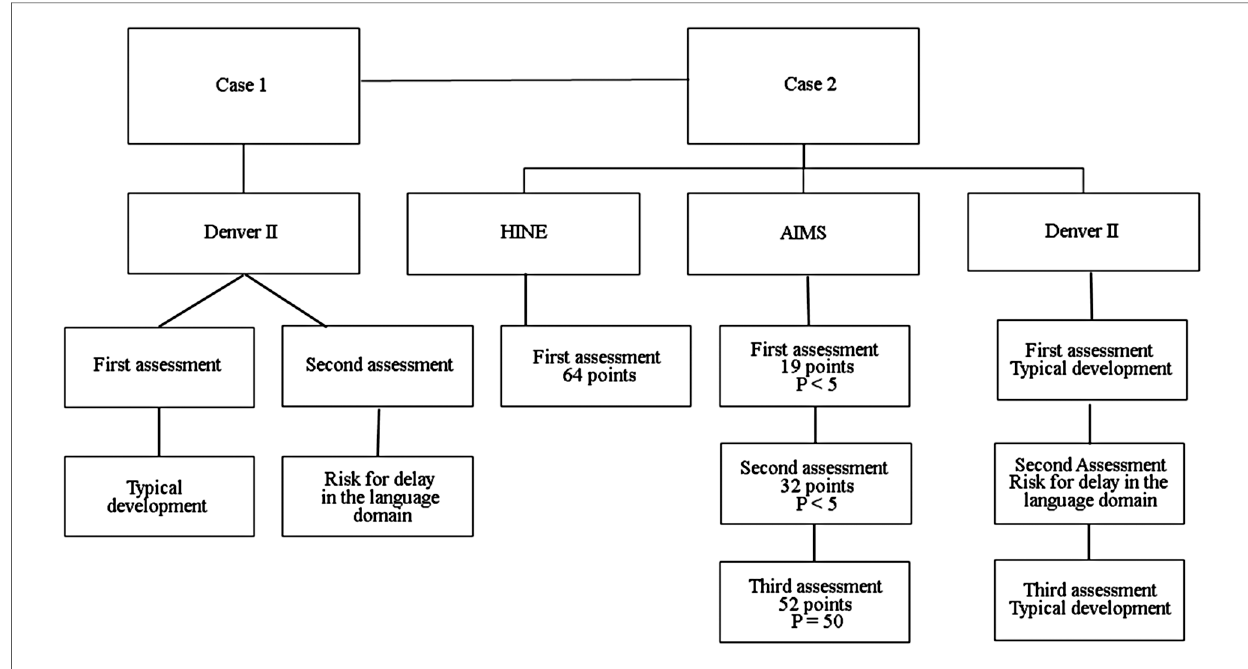
FIGURE 1 Instruments to assess the two cases. P,